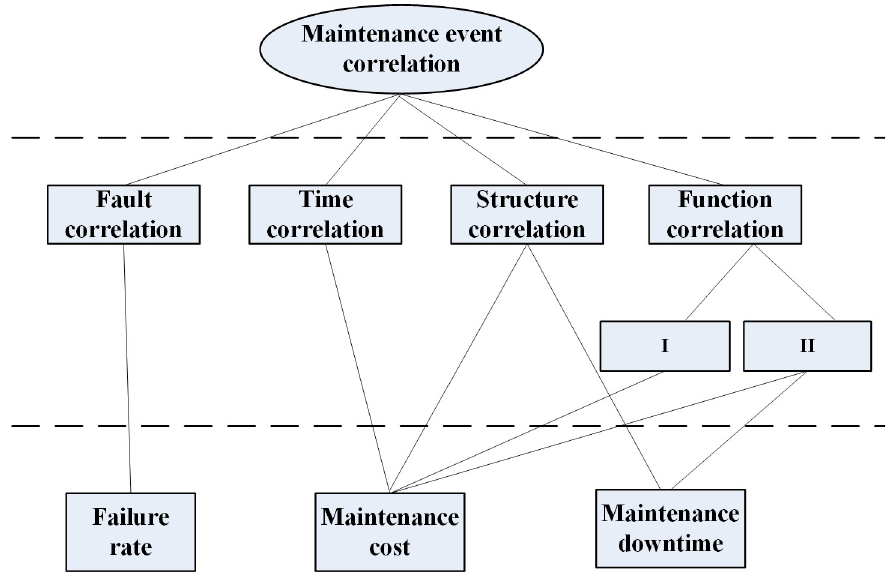
Fig 4. Impact of maintenance event correlation on maintenance downtime and cost.